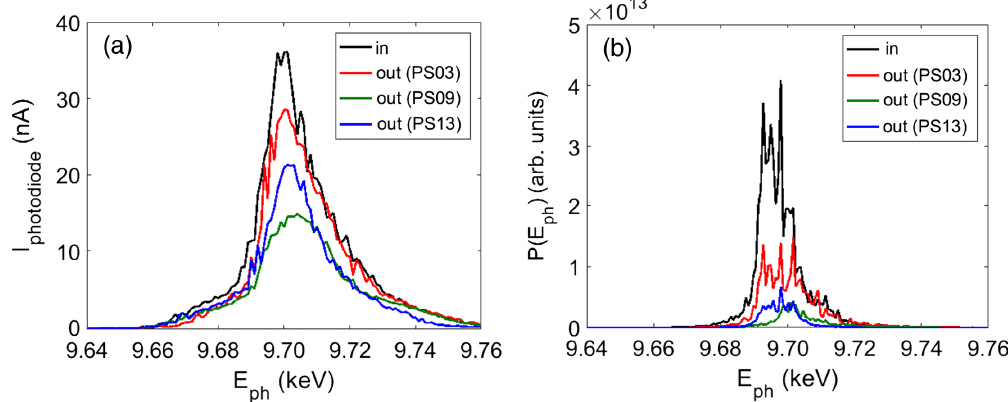
FIG. 6. FEL spectrum from (a) experiment and (b) simulation at the end of the undulator line for four cases: in phase (black) and out of phase of the phase shifter at 18 (red), 54 (green), and 78 m